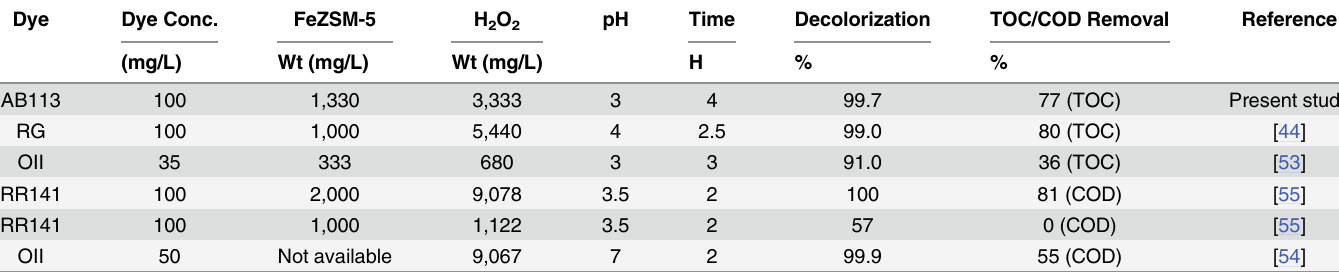
Table 14. Efficiency comparison chart of different Fe-ZSM-5 catalysts used for the degradation of dyes. Dye Dye